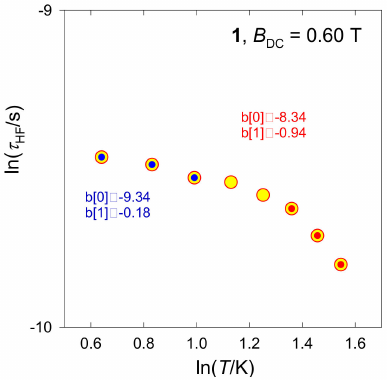
Figure 9. Thermal development of the relaxation time for the high-frequency relaxing species of 1